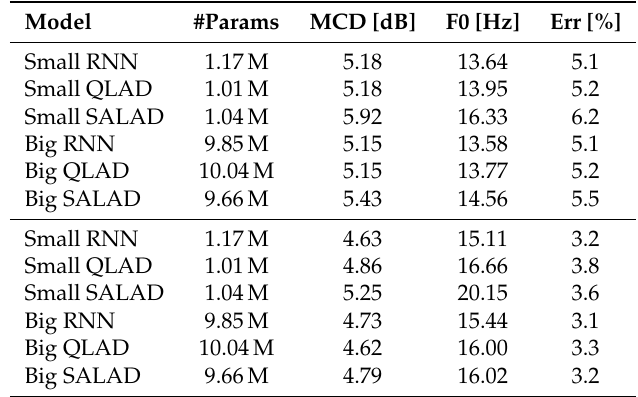
Table 2. Male (top) and female (bottom) objective results. Err, unvoiced–voiced classification error.